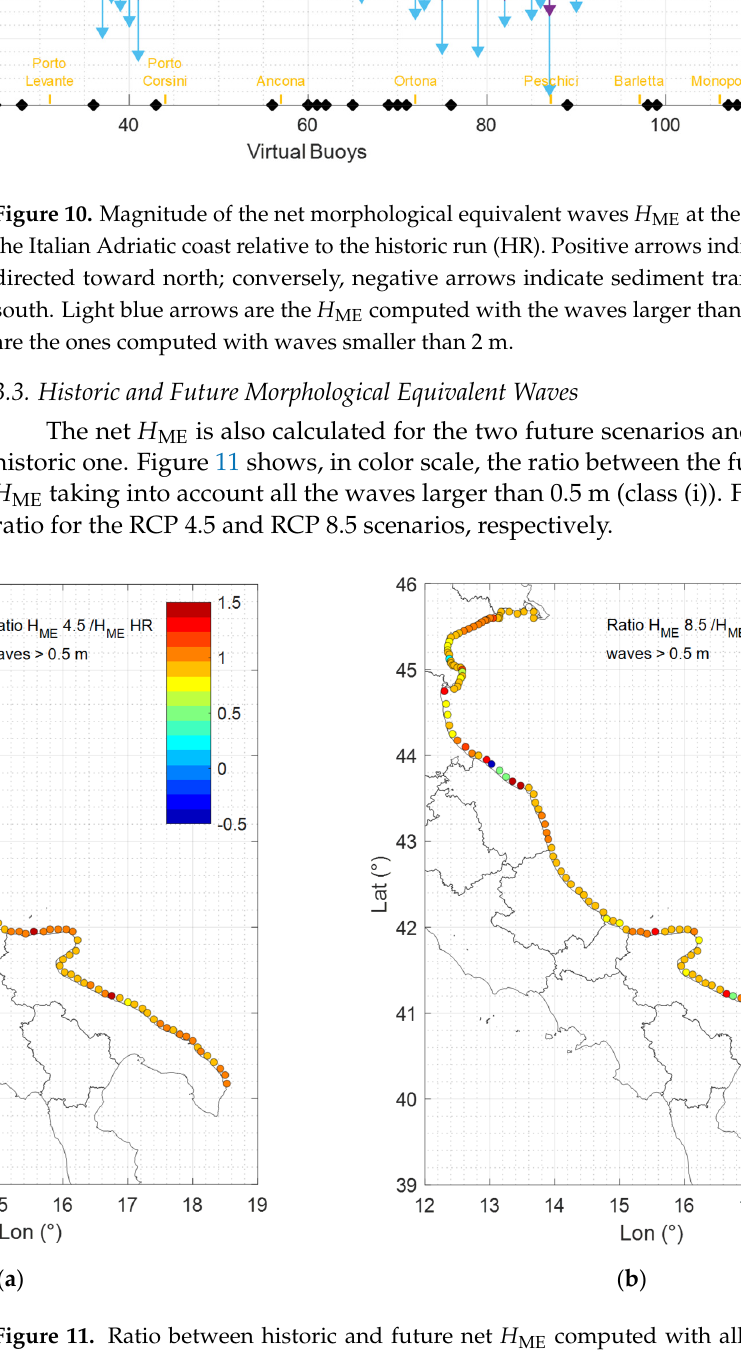
Figure 9. Direction of the morphological wave heights H ME along the Italian Adriatic coast. The H ME value is evaluated taking into account all waves with Hs > 0.5 m for the historic run.